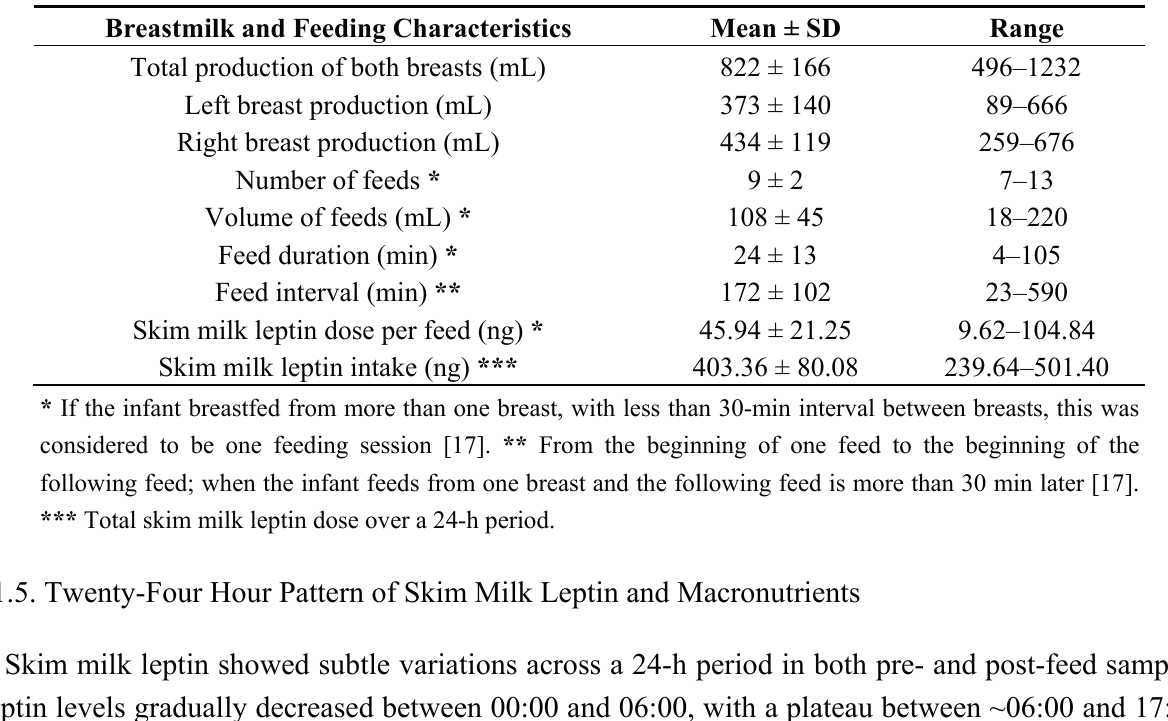
Table 3. Breastmilk production and infant feeding characteristics over a 24-h period for 19 breastfeeding dyads (Mean ±